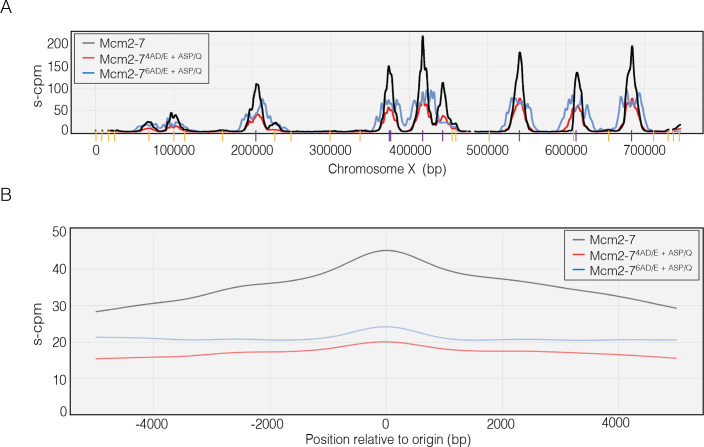
Dbf4-dependent kinase (DDK)-dependent phosphorylation sites on the N-terminal tails of Mcm4 and Mcm6 promote origin initiation.(A) Impact of Mcm4 and Mcm6 N-terminal DDK phosphosite mutations at specific origins of replication. Normalized sequence read numbers are reported for 5-bromo-2-deoxyuridine (BrdU)-labeled DNAs across the length of Saccharomyces cerevisiae chromosome X for strains expressing wild-type Mcm2–7 (yML514), Mcm2-74AD/E+ASP/Q (yML512), or Mcm2-76AD/E+ASP/Q (yML513). Known origins of replication are represented by vertical lines at the bottom of the plot. Early origins are represented with purple vertical lines (origins with time of replication <20 min; Yabuki et al., 2002; Siow et al., 2012), whereas non-early origins are represented by yellow vertical lines. (B) Impact of Mcm4 and Mcm6 N-terminal DDK phosphorylation site mutations across all origins. The average BrdU sequence read depth (s-cpm) for strains expressing wild-type Mcm2–7, Mcm2-74AD/E+ASP/Q, or Mcm2-76AD/E+ASP/Q is reported for DNA sequences flanking all origins of replication. Origins were aligned with respect to the midpoint of each origin.